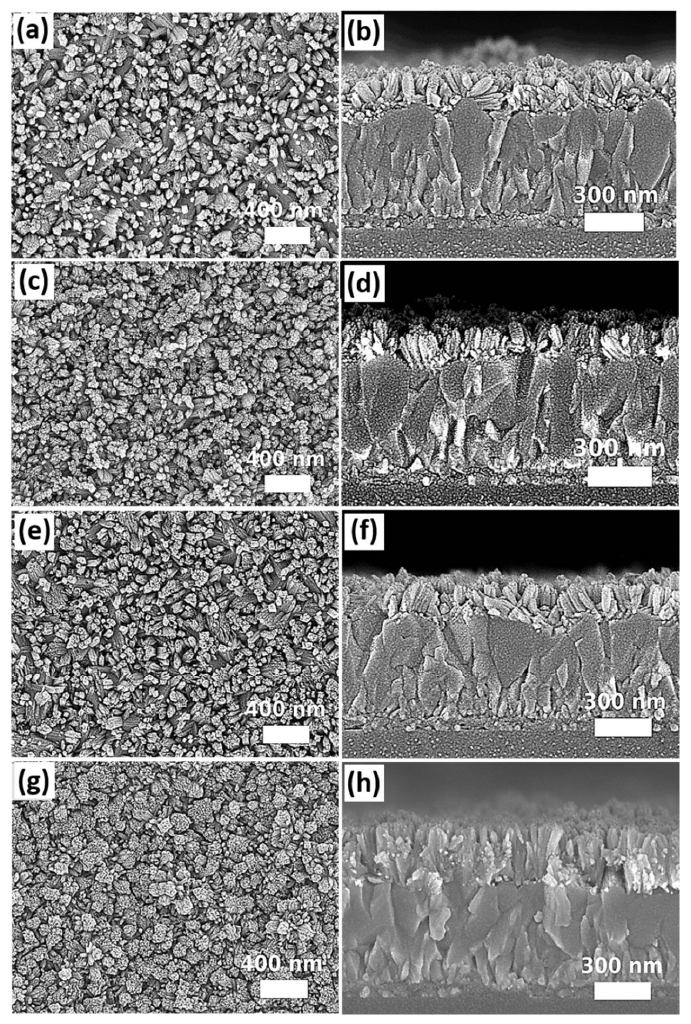
Figure 7. The top-view and cross-sectional SEM images of SnO 2 grown by solvothermal method for ( a , b ) 6 h, ( c , d ) 12 h, ( e , f ) 24 h, and ( g , h ) 12 + 12 h (two-step process).